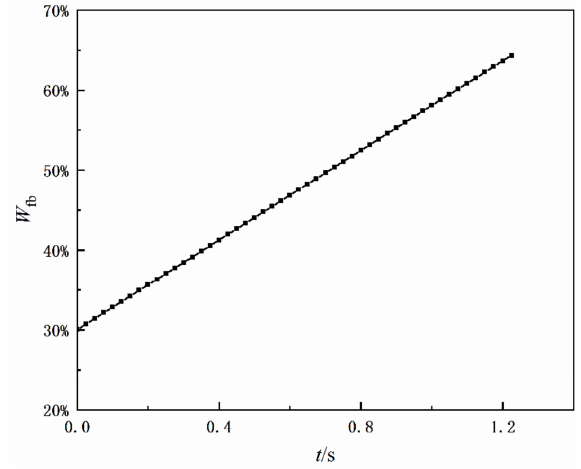
Figure 11. Variation curve of fuel flow rate during